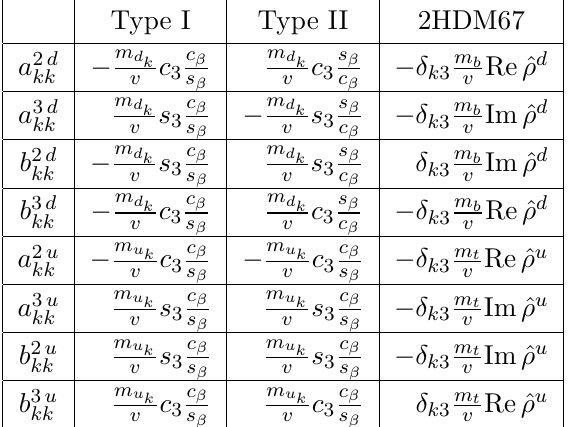
and b (cid:11)q for the Type I, Type II models and for the generic 2HDM in kk kk